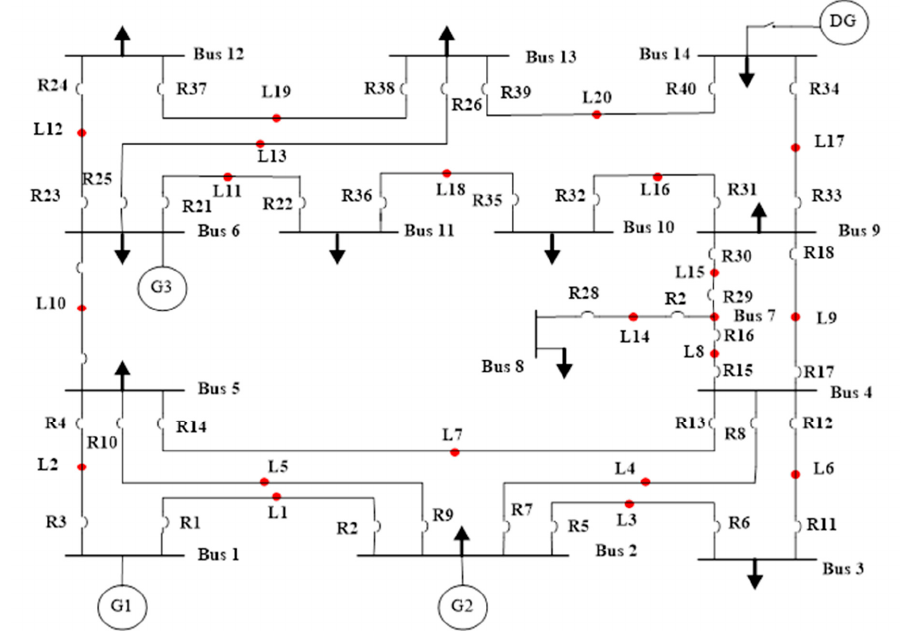
Figure 5. Single line diagram of IEEE 14-bus system. Table 6. CT ratio between the relays for the IEEE 14-bus system.